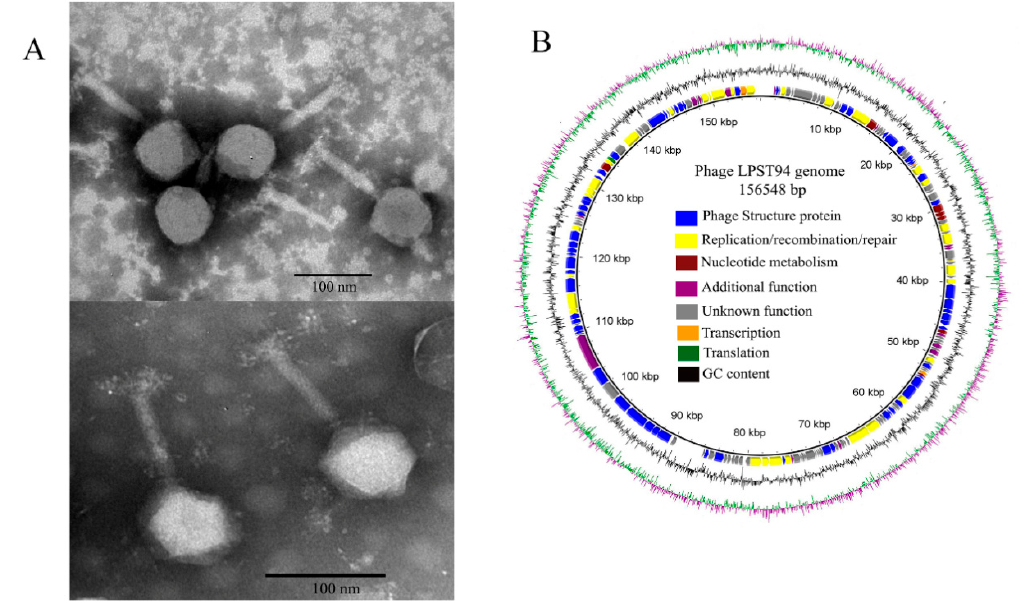
Figure 2. Morphological and genomic characteristics of phage LPST94. ( A ) TEM image of phage LPST94; Bar 100 nm, and ( B ) Genome map of phage LPST94. Patterns were divided into four circles: the full length of the genome was indicated in the first circle; the open reading frame was indicated in the second circle, and the clockwise arrow and the counterclockwise arrow represented the forward reading frame and the reverse reading frame, respectively; GC content was indicated in the third circle; while on the fourth circle, GC skew of G-C / G + C was indicated as green and purple, and green meant the values of GC skew greater than 0 and purple meant the values less than 0. The open reading frames marked with the color of each gene refers to the functional category: phage structure (blue), replication / recombination / repair (yellow), nucleotide metabolism (maroon), transcription (orange), translation (green) additional function (purple) and hypothetical proteins (grey). The genome map generated by the BRIG.jar